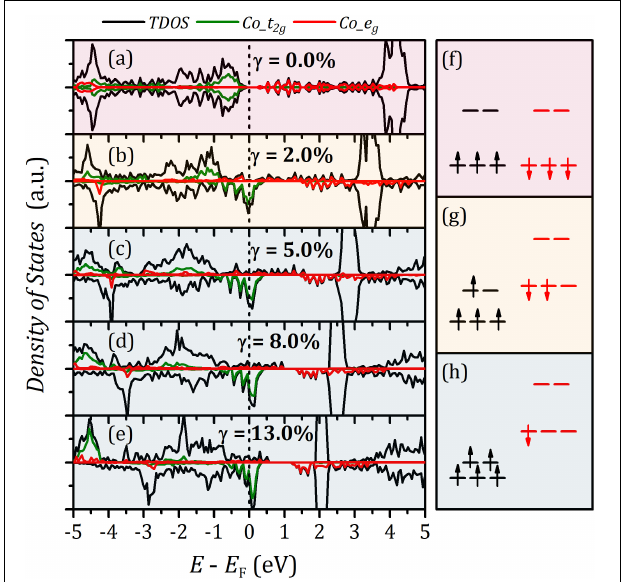
FIGURE 4 | Density of states of LaCoO 3 under various strain: (a–e) γ = 0.0, 2.0, 5.0, 8.0, and 13.0%. The schematic diagram of crystal field and corresponding spin arrangements: (f) low spin, (g) intermediate spin, and (h) high